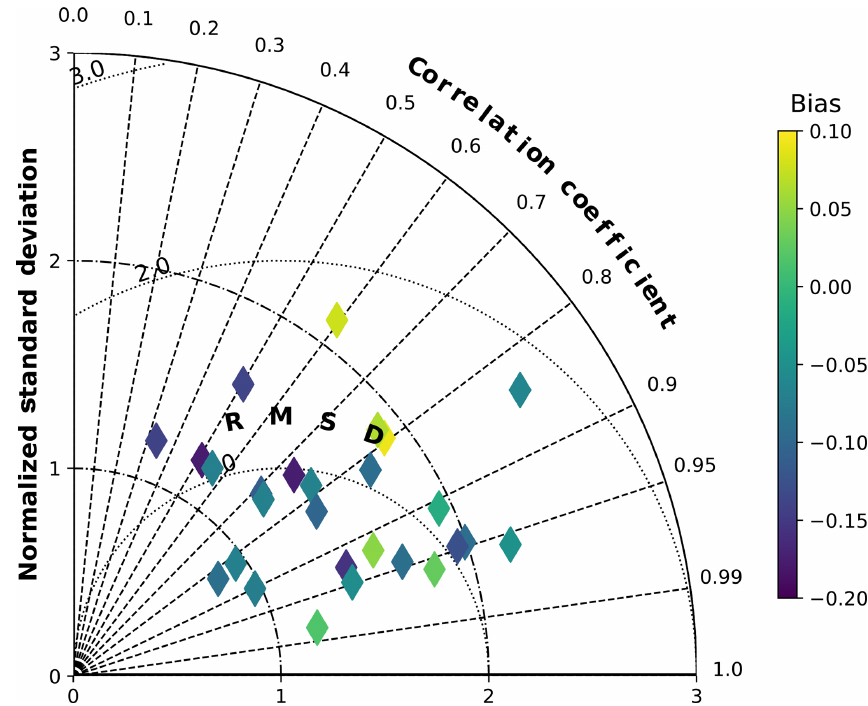
Figure A7. Taylor diagram showing agreement between FP sensors and professional probes at a depth of 10cm.